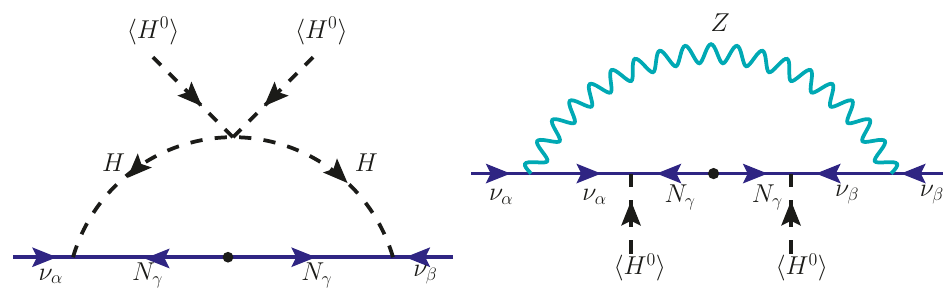
Figure 37 . One-loop neutrino mass in the minimal radiative inverse seesaw model [43]. This model 0 induces the operator of eq. 2 O